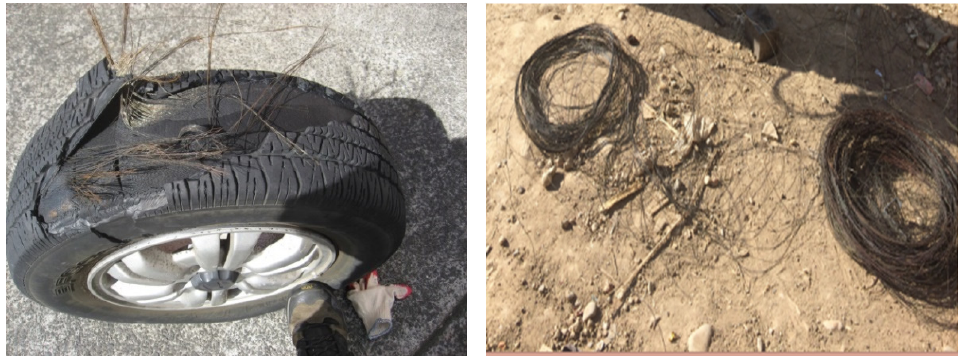
Figure 2. Gradation curve of coarse aggregate.